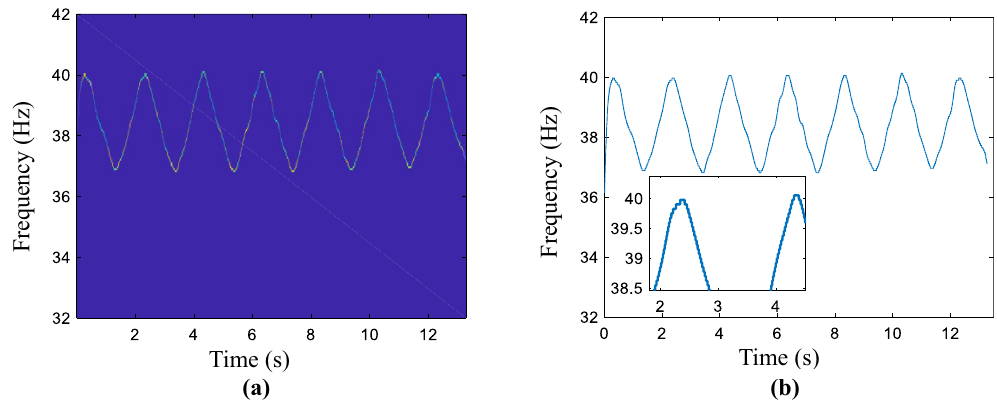
Figure 6. Non-linear time-varying vibration signal. ( a ) Obtained time–frequency representation of the signal by using MSST, ( b ) corresponding coarse estimated